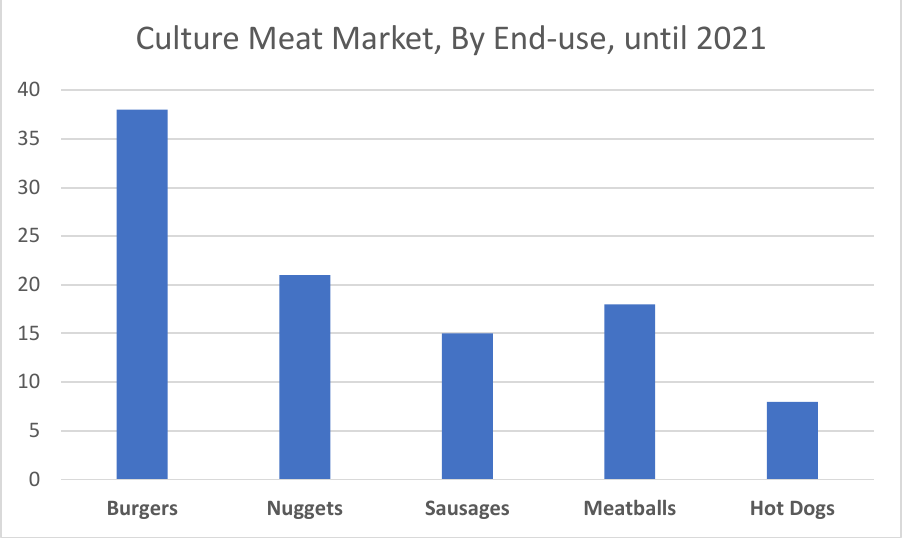
Figure 2. Cultured Meat Market (percentage), By End-use until the end of 2021 (based on reportlinnker.com [31]).